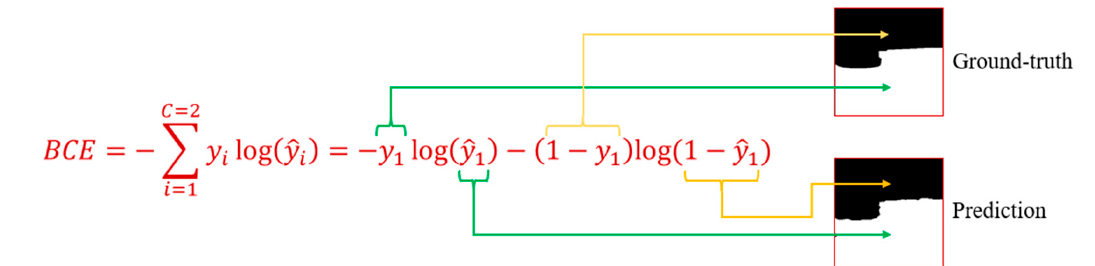
Figure 2. Ground truth and prediction in the loss function (BCE).